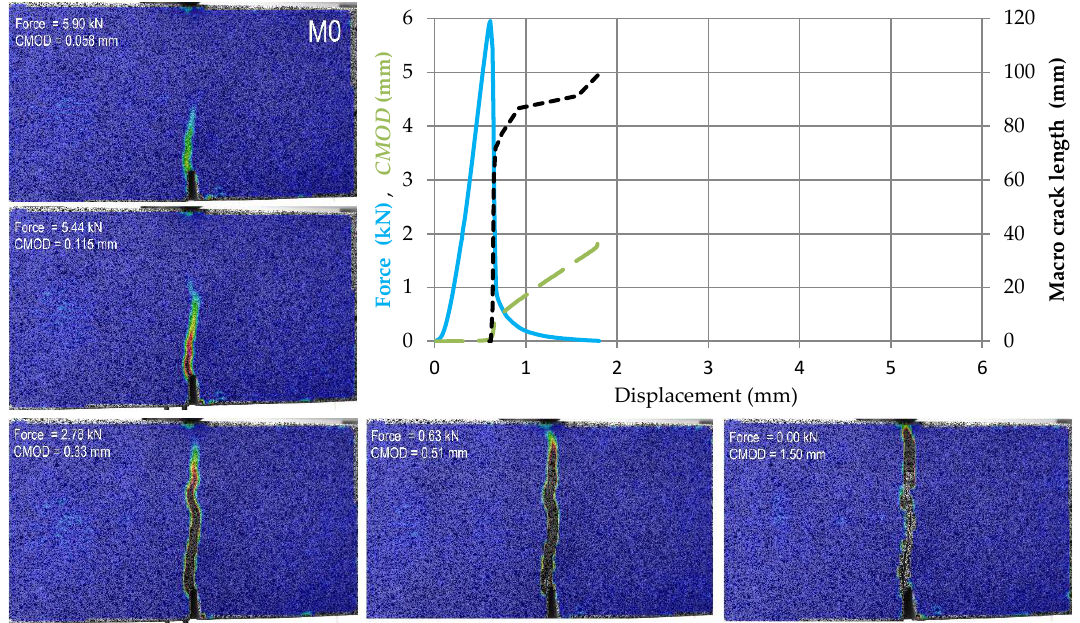
Figure 9. Force, CMOD and summary macro-crack length as a function of displacement in case of material M0 accompanied by cracks development in five chosen stages (contour plots of equivalent Huber–Mises strains).